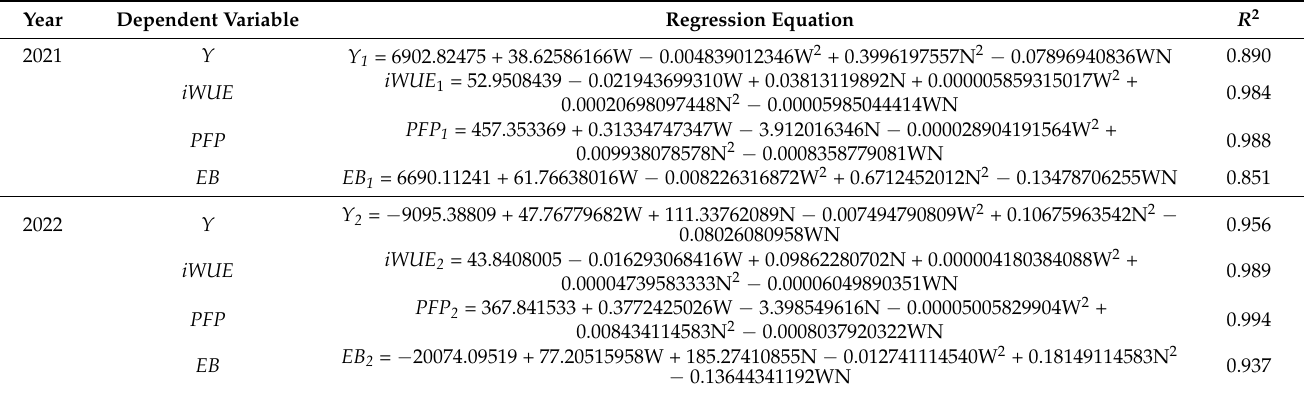
Table 4. Regression relationship between water and nitrogen regulation and yield, irrigation water use efficiency, nitrogen fertilizer bias productivity, and economic efficiency.